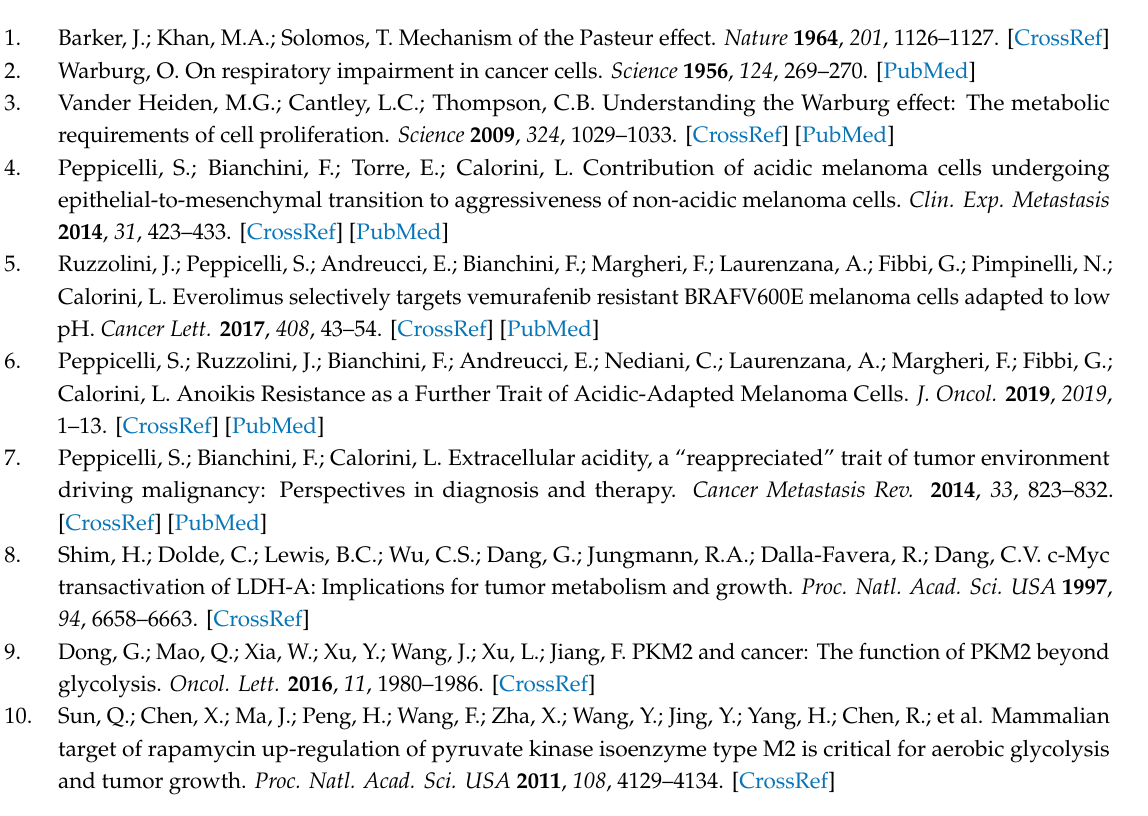
Figure S1: Cell growth of human MSC treated with OLEO 200 µ M, Figure S2: Detailed information of protein expression analysis by Western blot: (A) Original blot for the Figure 3B, (B) Densitometry and intensity ratio of each